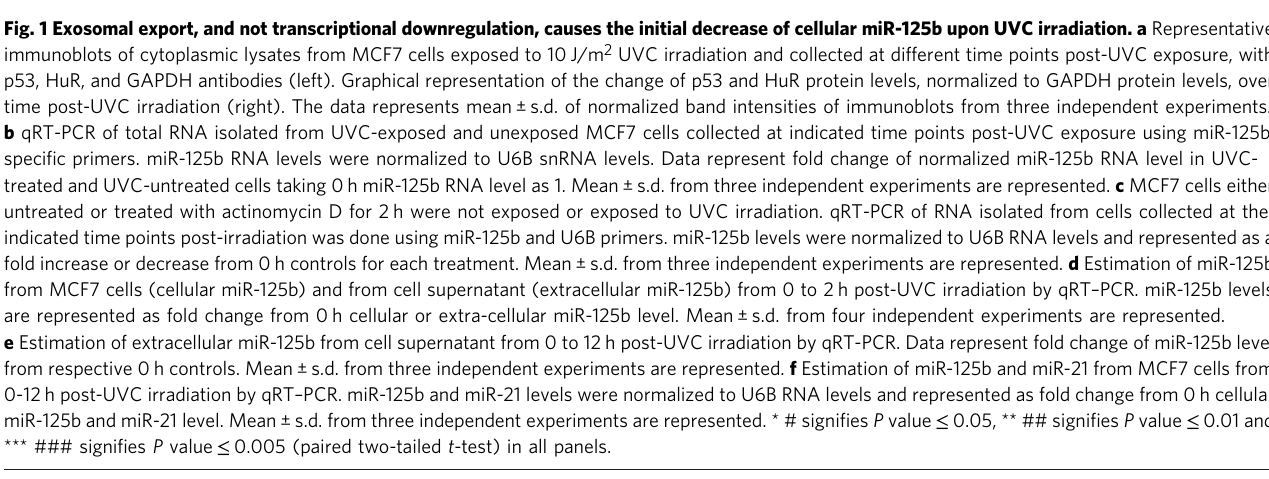
Fig. 1 Exosomal export, and not transcriptional downregulation, causes the initial decrease of cellular miR-125b upon UVC irradiation. a Representative immunoblots of cytoplasmic lysates from MCF7 cells exposed to 10 J/m 2 UVC irradiation and collected at different time points post-UVC exposure, with p53, HuR, and GAPDH antibodies (left). Graphical representation of the change of p53 and HuR protein levels, normalized to GAPDH protein levels, over time post-UVC irradiation (right). The data represents mean ± s.d. of normalized band intensities of immunoblots from three independent experiments. b qRT-PCR of total RNA isolated from UVC-exposed and unexposed MCF7 cells collected at indicated time points post-UVC exposure using miR-125b speci fi c primers. miR-125b RNA levels were normalized to U6B snRNA levels. Data represent fold change of normalized miR-125b RNA level in UVC- treated and UVC-untreated cells taking 0 h miR-125b RNA level as 1. Mean± s.d. from three independent experiments are represented. c MCF7 cells either untreated or treated with actinomycin D for 2 h were not exposed or exposed to UVC irradiation. qRT-PCR of RNA isolated from cells collected at the indicated time points post-irradiation was done using miR-125b and U6B primers. miR-125b levels were normalized to U6B RNA levels and represented as a fold increase or decrease from 0 h controls for each treatment. Mean± s.d. from three independent experiments are represented. d Estimation of miR-125b from MCF7 cells (cellular miR-125b) and from cell supernatant (extracellular miR-125b) from 0 to 2 h post-UVC irradiation by qRT – PCR. miR-125b levels are represented as fold change from 0 h cellular or extra-cellular miR-125b level. Mean ± s.d. from four independent experiments are represented. e Estimation of extracellular miR-125b from cell supernatant from 0 to 12 h post-UVC irradiation by qRT-PCR. Data represent fold change of miR-125b level from respective 0 h controls. Mean ± s.d. from three independent experiments are represented. f Estimation of miR-125b and miR-21 from MCF7 cells from 0-12 h post-UVC irradiation by qRT – PCR. miR-125b and miR-21 levels were normalized to U6B RNA levels and represented as fold change from 0 h cellular miR-125b and miR-21 level. Mean ± s.d. from three independent experiments are represented. * # signi fi es P value ≤ 0.05, ** ## signi fi es P value ≤ 0.01